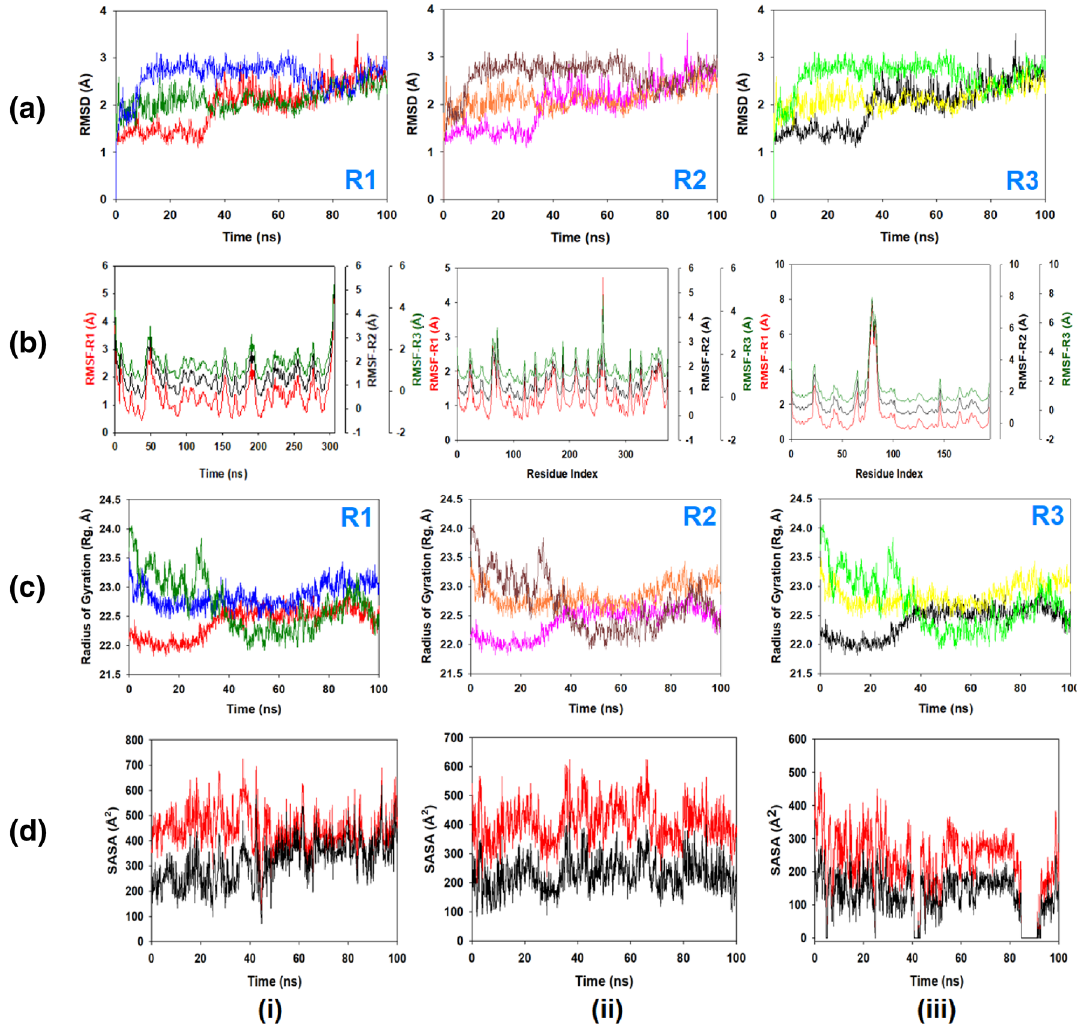
Figure 8. MD simulation trajectory analysis from 100 ns time frame in triplicate displayed ( A ) R1 (replicate 1) RMSD plots of DAPH + Cl − bound M pro (red), nsp2 (green) and nsp7-nsp8 (blue), R2 (replicate 2) RMSD plots of DAPH + Cl − bound M pro (purple), nsp2 (orange) and nsp7-nsp8 (dark red), R3 (replicate 3) RMSD plots of DAPH + Cl − bound M pro (black), nsp2 (yellow) and nsp7-nsp8 (parrot green); ( B ) [Replicate (1, 2, 3), left panel]: RMSF plots of DAPH + Cl − bound M pro , [replicate (1, 2, 3), middle panel]: RMSF plots of DAPH + Cl − bound nsp2, and [replicate (1, 2, 3), right panel]: RMSF plots of DAPH + Cl − bound nsp7-nsp8. The RMSF plots of three replicates coded color (red, R1), (black R2) and (green R3). The Y axis scales were adjusted to display the individual replicate plots; ( C ) R1 (replicate 1) Radius of gyration (Rg) plots of DAPH + Cl − bound M pro (red), nsp2 (green) and nsp7-nsp8 (blue), R2 (replicate 2) Radius of gyration (Rg) plots of DAPH + Cl − bound M pro (purple), nsp2 (orange) and nsp7-nsp8 (dark red), R3 (replicate 3) Radius of gyration (Rg) plots of DAPH + Cl − bound M pro (black), nsp2 (yellow) and nsp7-nsp8 (parrot green); ( D ) Binding SASA in the presence (black) and absence (red) of DAPH + Cl − with M pro (left panel), nsp2 (middle panel) and nsp7-nsp8 (right panel). Lowering of SASA (black) signify the binding of ligand to the respective